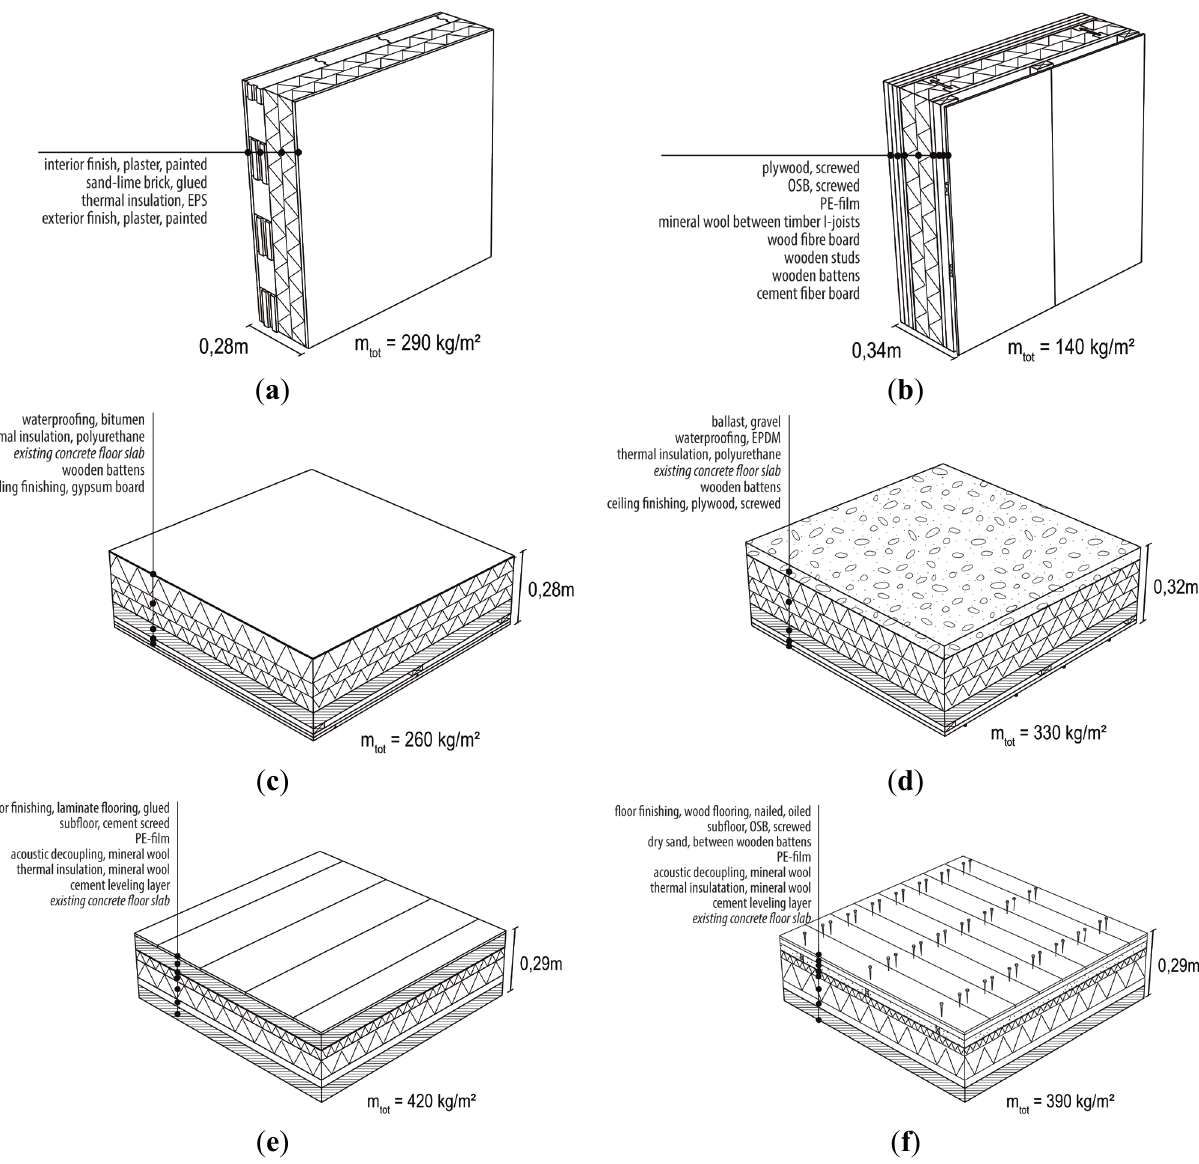
Figure 3. For each building element and strategy a conventional and demountable detailing has been proposed, e.g., a conventional ( a ) and demountable ( b ) external wall, and a conventional ( c ) and demountable ( d ) flat roof, all transformed with external insulation; a conventional ( e ) and demountable ( f ) ground floor, transformed with internal